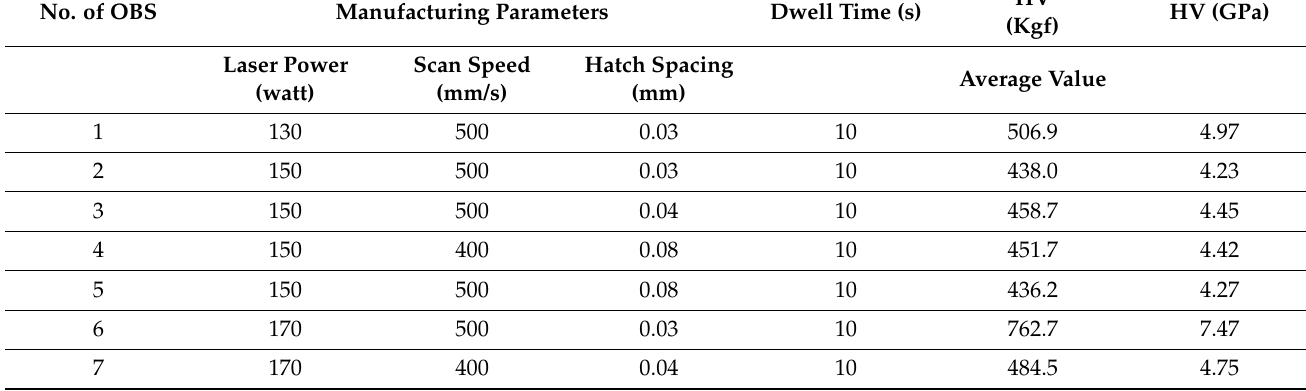
Table 2. Observation table for